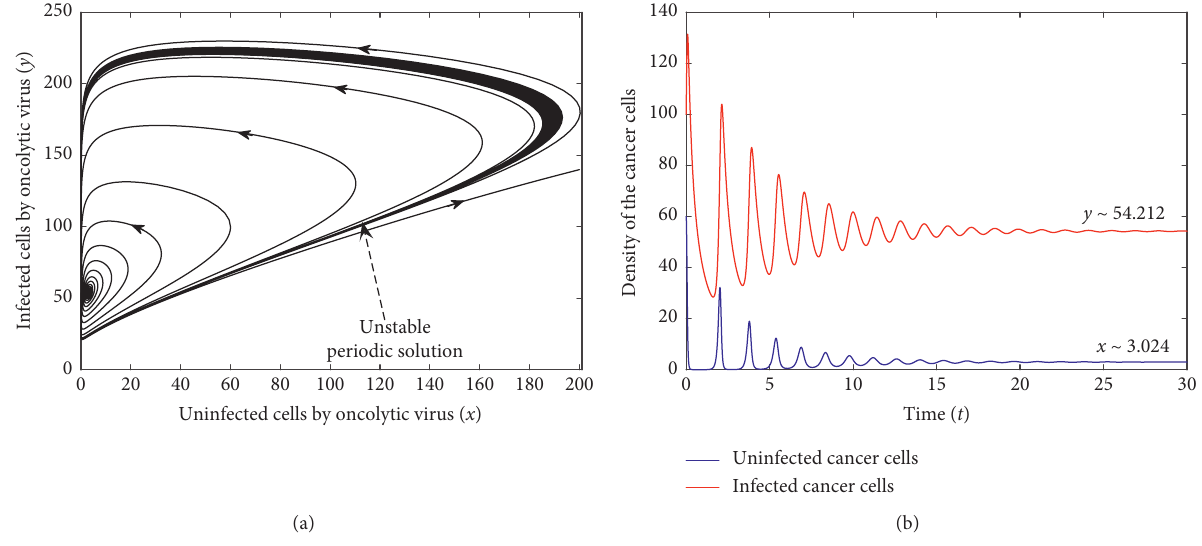
Figure 2: (a) Phase portrait of system (1) for p � − 0 . 52. (b) Trajectory of the solutions which converge to the stable equilibrium point ( x,y ) ≈ ( 3 . 024 , 54 , 212 )